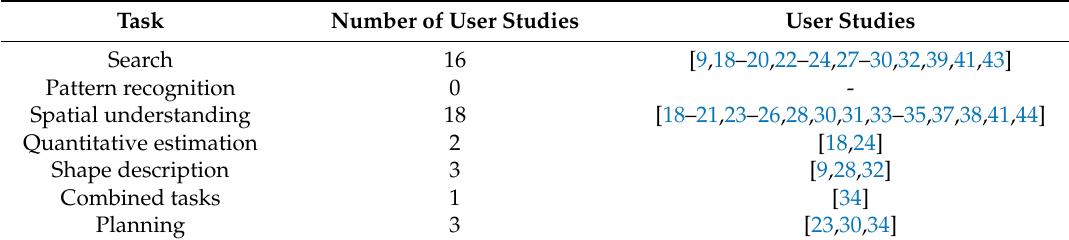
Table 1. Taxonomy of tasks in empirical research of 3D maps (ranked from the simplest to the most complex task according to Juˇr í k, Herman and Šašinka [42]) with the given number of studies using this type of